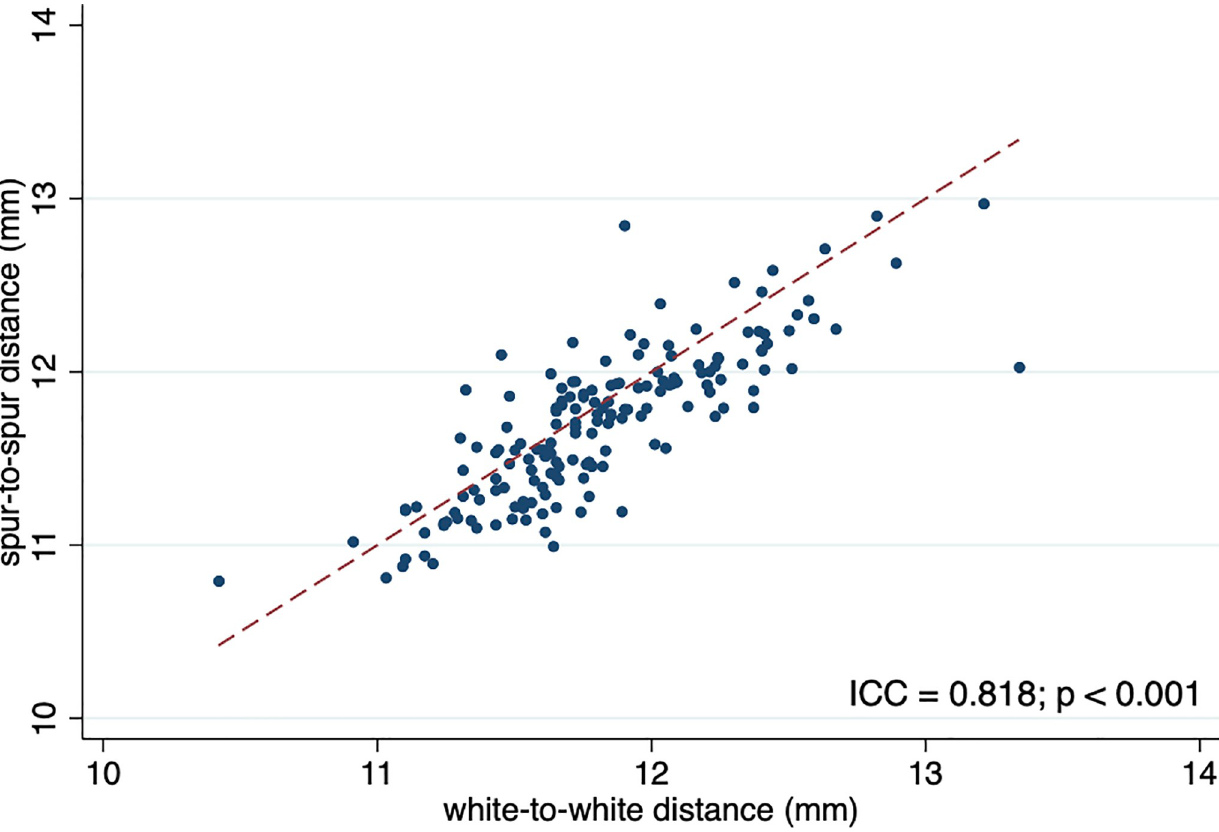
Fig 2. Scatter plot of spur-to-spur distance with respect to white-to-white distance. ICC, intraclass correlation coefficient; dashed line indicates the equality